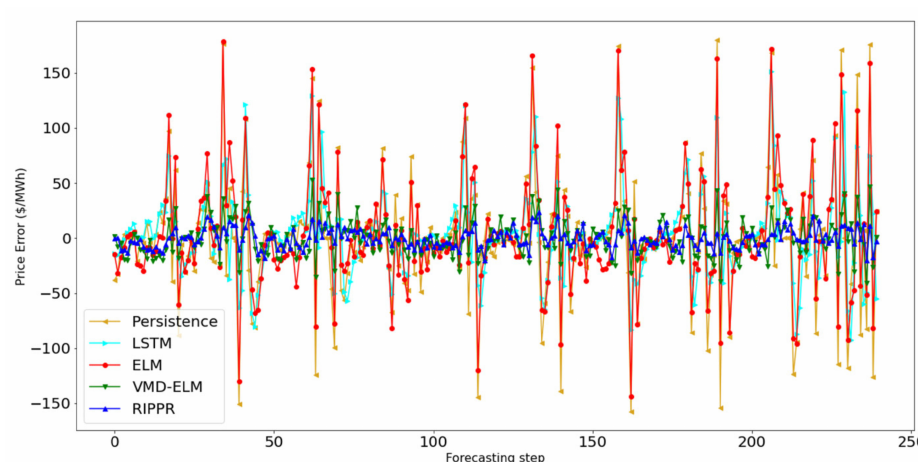
Figure 7. Forecasting error-one step ahead forecasting for dataset